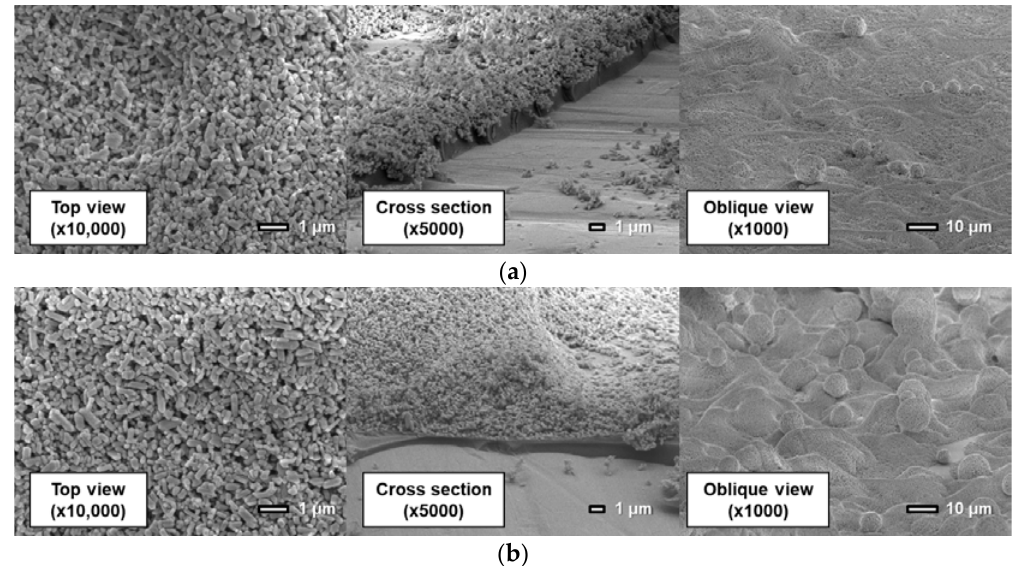
Figure 13. Scanning electron microscope images of the PD-adsorbed PSP the particle/dye solvent of which is the mixture (toluene: methanol = 0.2: 0.8) with a particle content of ( a ) 80 wt% and ( b ) 93 wt%.